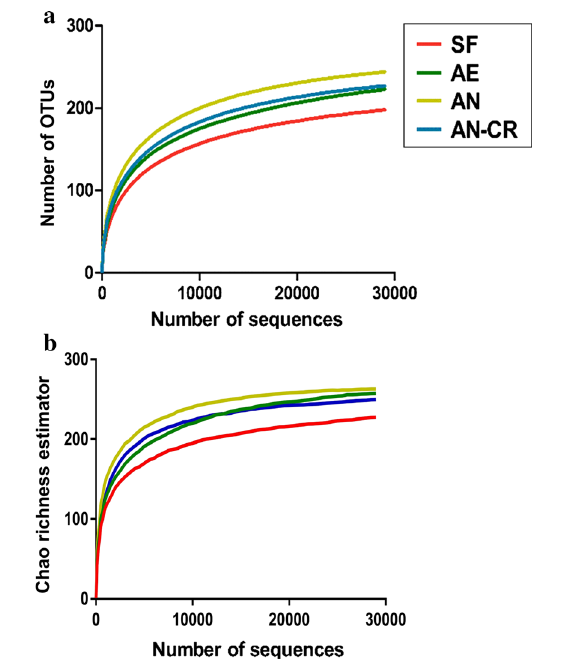
Fig. 2 Rarefaction curves plotting the number of phylotypes ( a ) and Chao richness estimator ( b ) in the 16Sr RNA gene libraries by the number of sequences from active microbiota in all groups. SF sows’ fecal group, AE aerobic group, AN anaerobic group, AE-CR anaerobic-cryopreserved